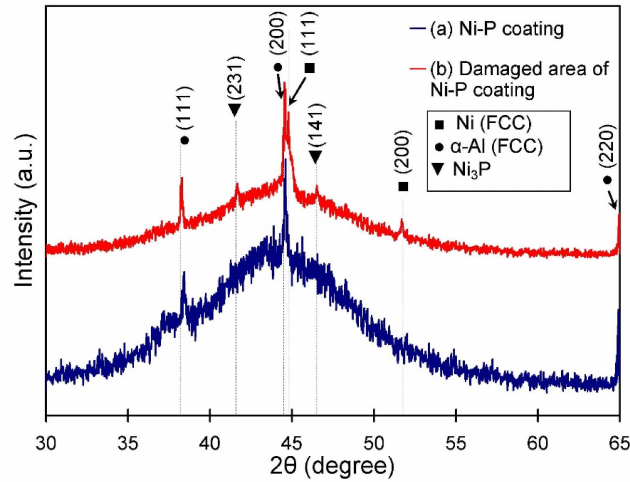
Figure 4. X-ray diffraction patterns of: ( a ) electroless Ni–P coatings; and ( b ) damaged area of Ni–P